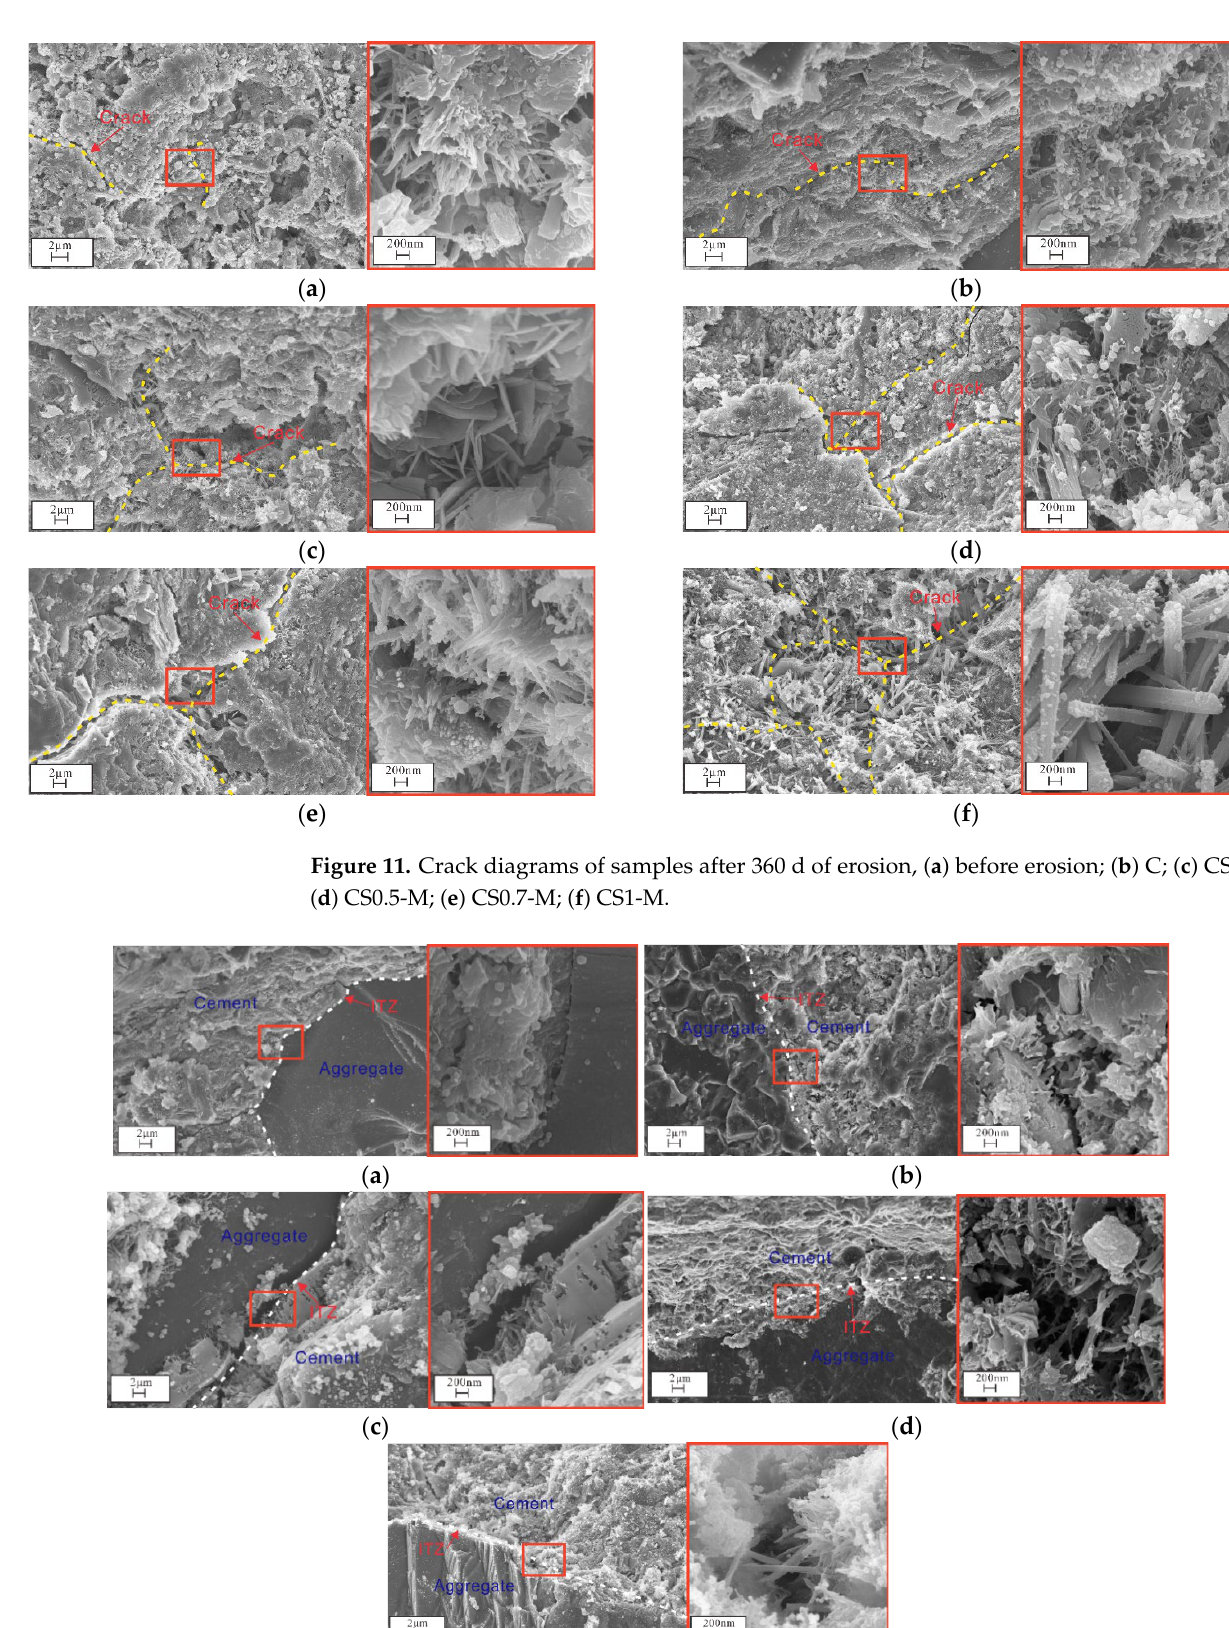
Figure 10. SEM images and EDS analyses after NaCl-MgSO 4 (CS1-M) erosion for 360 d: ( a ) C–S–H,